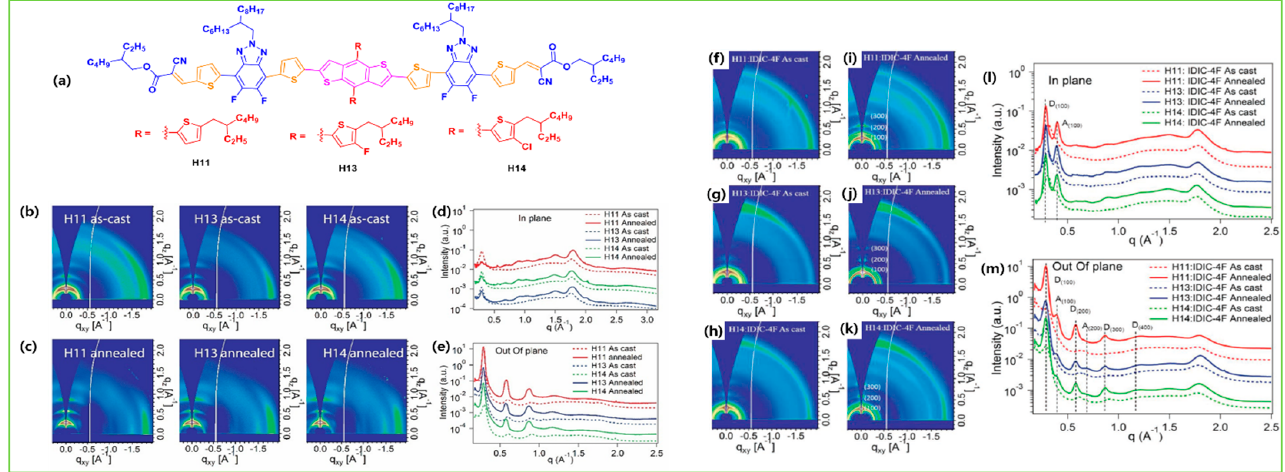
Figure 16. ( a ) Chemical structure of H11, H13, and H14 donors. ( b , c ) Two-dimensional GIWAXS patterns without and with thermal annealing. ( d , e ) In-plane and out-of-plane 1D line cuts of the neat donor films without and with thermal annealing. ( f – k ) Two-dimensional GIWAXS patterns. ( l , m ) In-plane and out-of-plane scattering profiles of the blend films without and with thermal annealing. Adapted with permission from [83]. Copyright 2020, John Wiley and Sons.